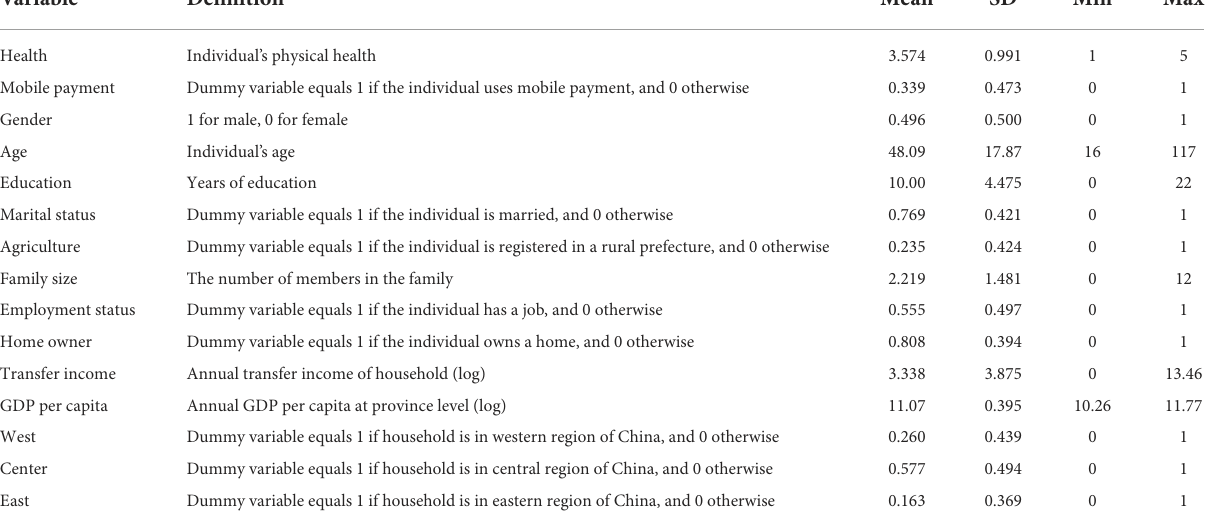
TABLE 1 Descriptive statistics.